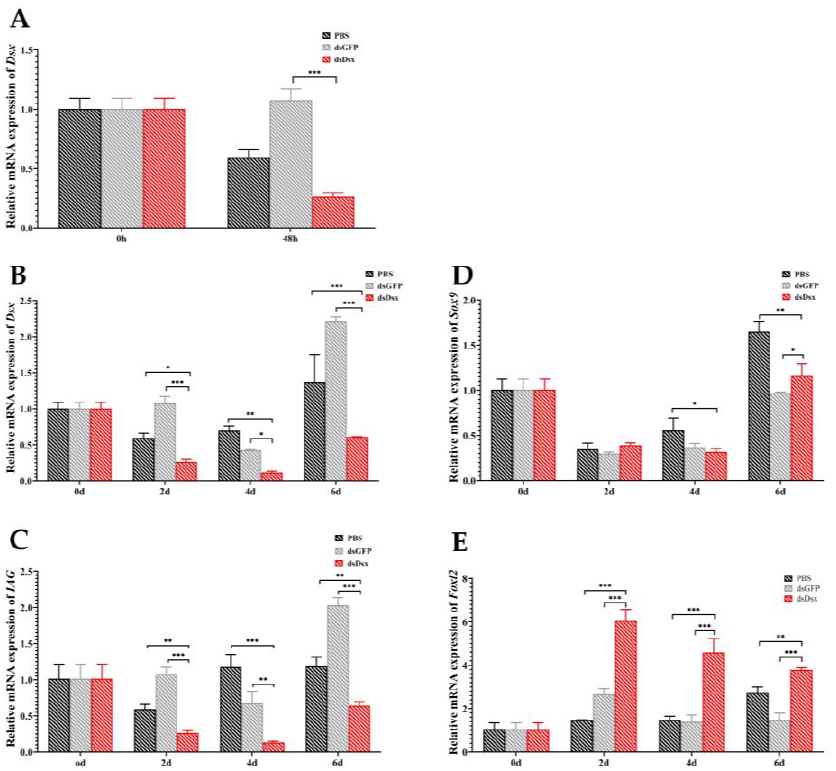
Figure 6. Time-dependent silencing effect of PmDsx , PmIAG , PmSox9 , and PmFoxl2 in testis. The interference efficiency of PmDsx ( A ) and the expression of PmDsx ( B ), PmIAG ( C ), PmSox9 ( D ), and PmFoxl2 ( E ) at 0, 2, 4, and 6 days after dsPmDsx injection were analyzed by qRT-PCR. The PBS and dsGFP groups were the control group. Three individuals were pooled as one sample and three replicates were used for analysis. The bars represent the mean ± standard deviation ( n = 3), and different asterisks indicate statistically significant differences (*** is p ≤ 0.0001, ** is p ≤ 0.001, * is ≤ 0.01) .